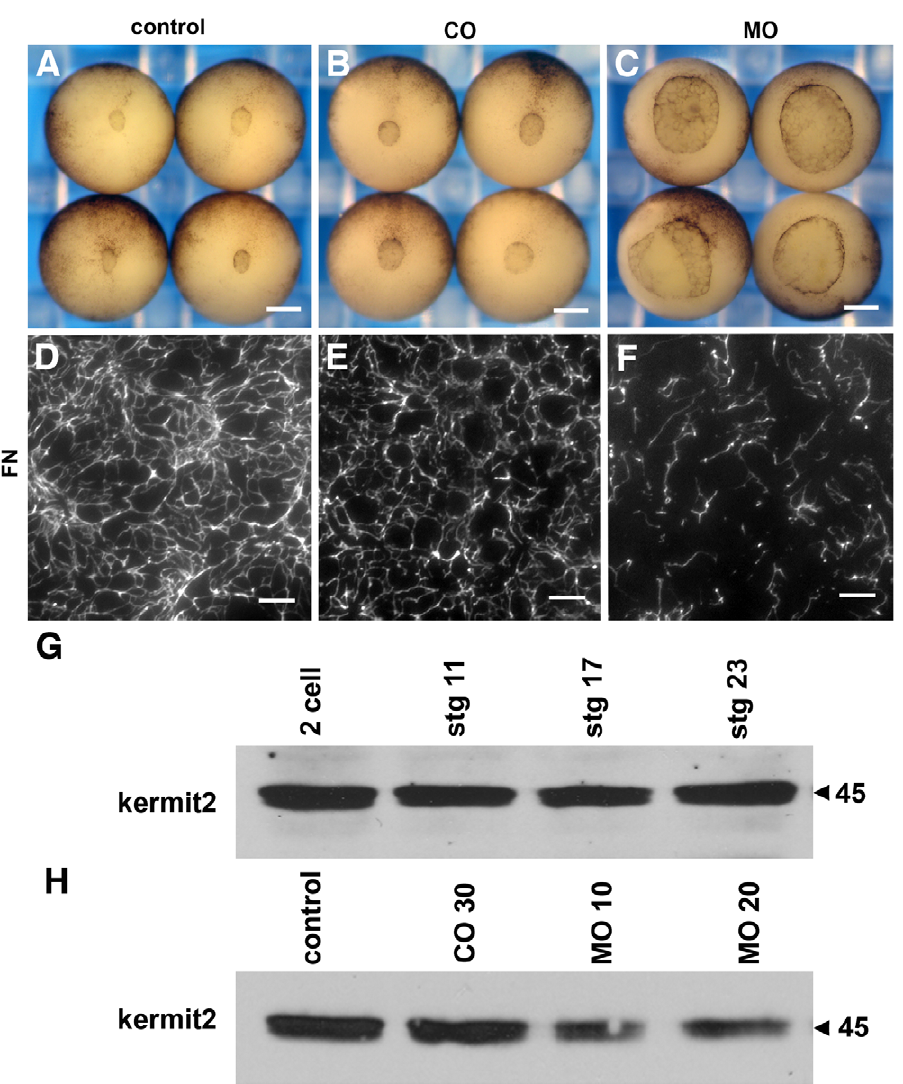
Figure 4. Morpholino knock down of kermit2 inhibits gastrulation and FN matrix assembly. (A–C) Ventral view of stage 12 embryos. (D– F) Late gastrula stage BCR stained for FN. (A) Stage 12 control embryos gastrulate normally and (D) assemble a dense FN matrix. Embryos injected with 20 ng of Kermit2 5 mismatch control morpholino (COMO; B) gastrulate normally, and (E) exhibit a small decrease in FN matrix assembly. (C) Embryos injected with kermit2 inhibiting morpholino (MO) exhibit delayed blastopore closure and (F) a sparse FN matrix network. (G) Western blot of kermit2 expression. Kermit2 is expressed throughout early development. (H) Morpholino knock down of kermit2 in stage 11 embryos. 30 ng of control morpholino (CO 30) has no effect on Kermit2 expression. The Kermit morpholino at 10 ng and 20 ng (MO 10 and MO 20) decreases kermit2 expression below control levels. Molecular mass is indicated to the left of the panel. (A–C) size marker =200 m m. (D–F) size marker =30 m m.